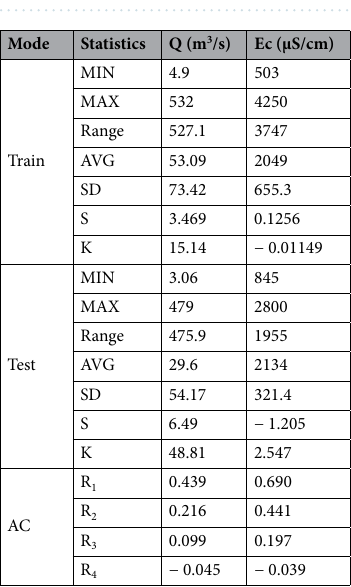
Figure 4. Original time series of Q (input) (upper graph) and EC (target) (lower graph) for all dataset.